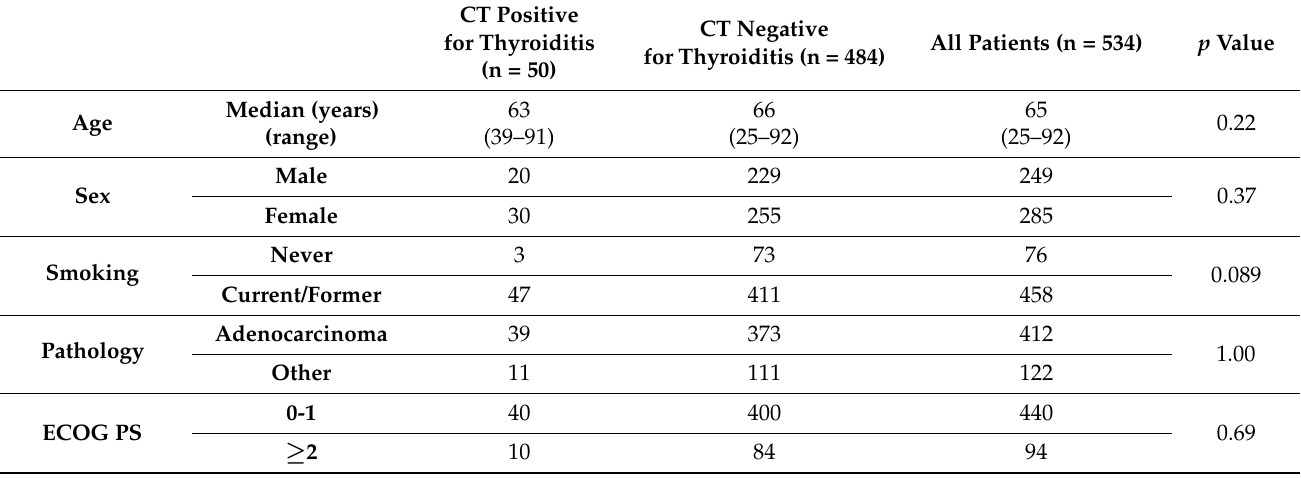
Table 1. Demographic and clinical